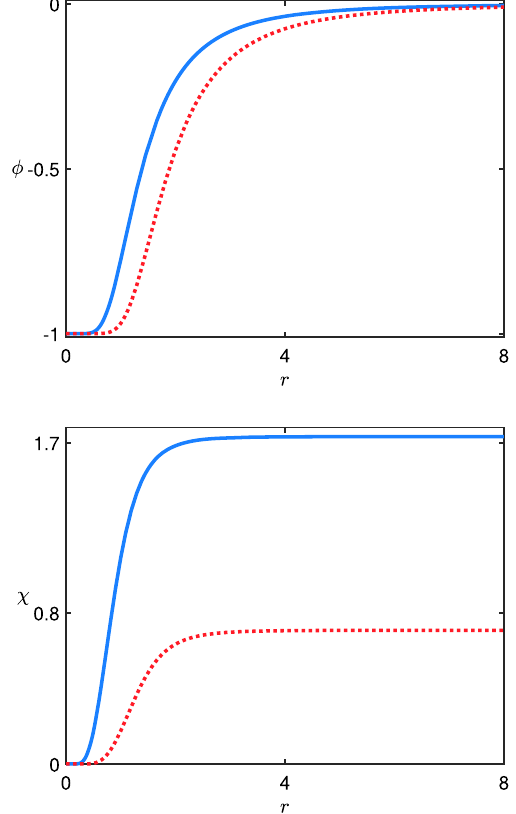
Fig. 15 The solution φ( r ) (top) and χ( r ) (bottom) associated to the model in Sect. 4.2.1 for σ = 5, α = 2 and n = 2 with k = 1 (solid, blue line) and 2 (dotted, red line)